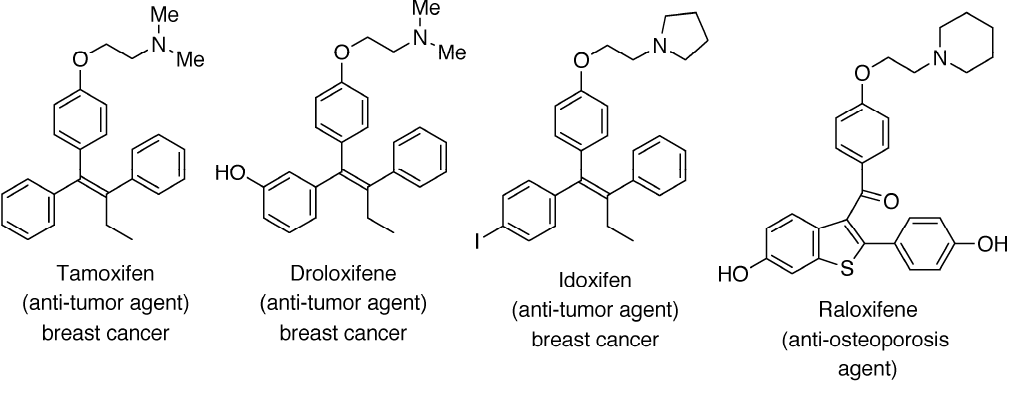
Figure 1. Structures of representive SERMs: tamoxifen, droloxifene, idoxifen, and raloxifene.